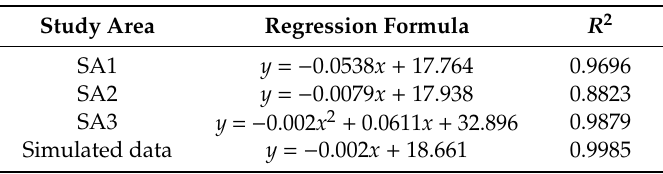
Table 7. Functional relationship between mean slope ( y ) and number of points in the neighbourhood ( x ) in study areas 1–3 and simulated data.